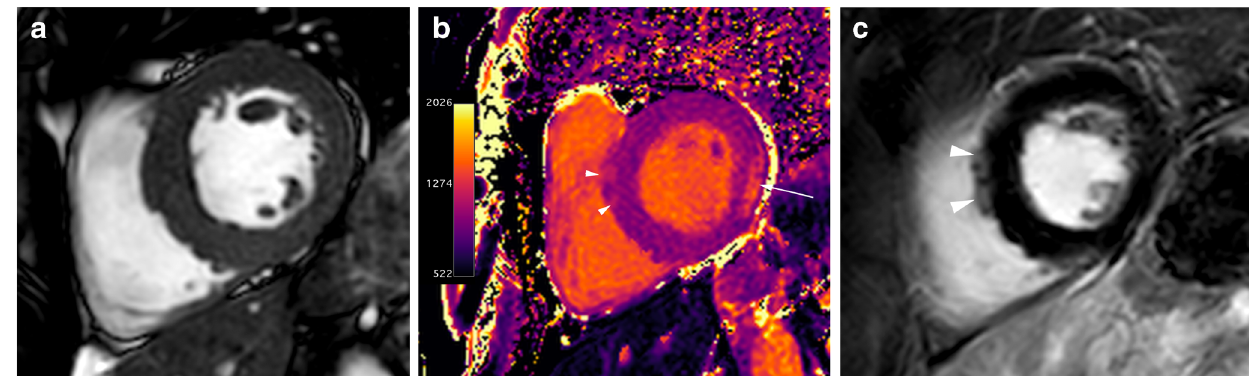
Fig. 8 T1 mapping in a 60-year-old man with septal HCM. a , End- diastolic short-axis SSFP cine MR image showing septal myocardial hypertrophy (20 mm). b , Short-axis non-enhanced MOLLI (modified looklockerinversion recovery) (1,5 T) T1mapdemonstratespatchy areas of prolonged T1 values in the anteroseptal segment (arrowheads;